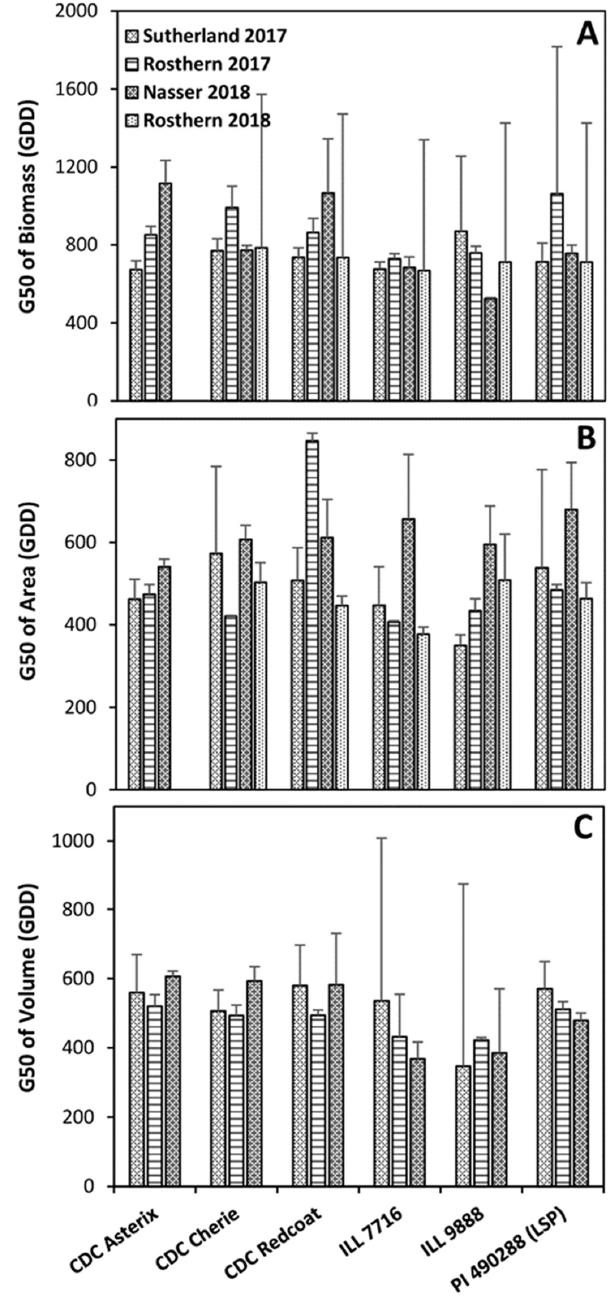
Figure 5. Estimate of G50: for dry weight biomass ( A ), vegetation area ( B ), and plot volume ( C ) of each genotype at each site-year. Error bars show standard error.